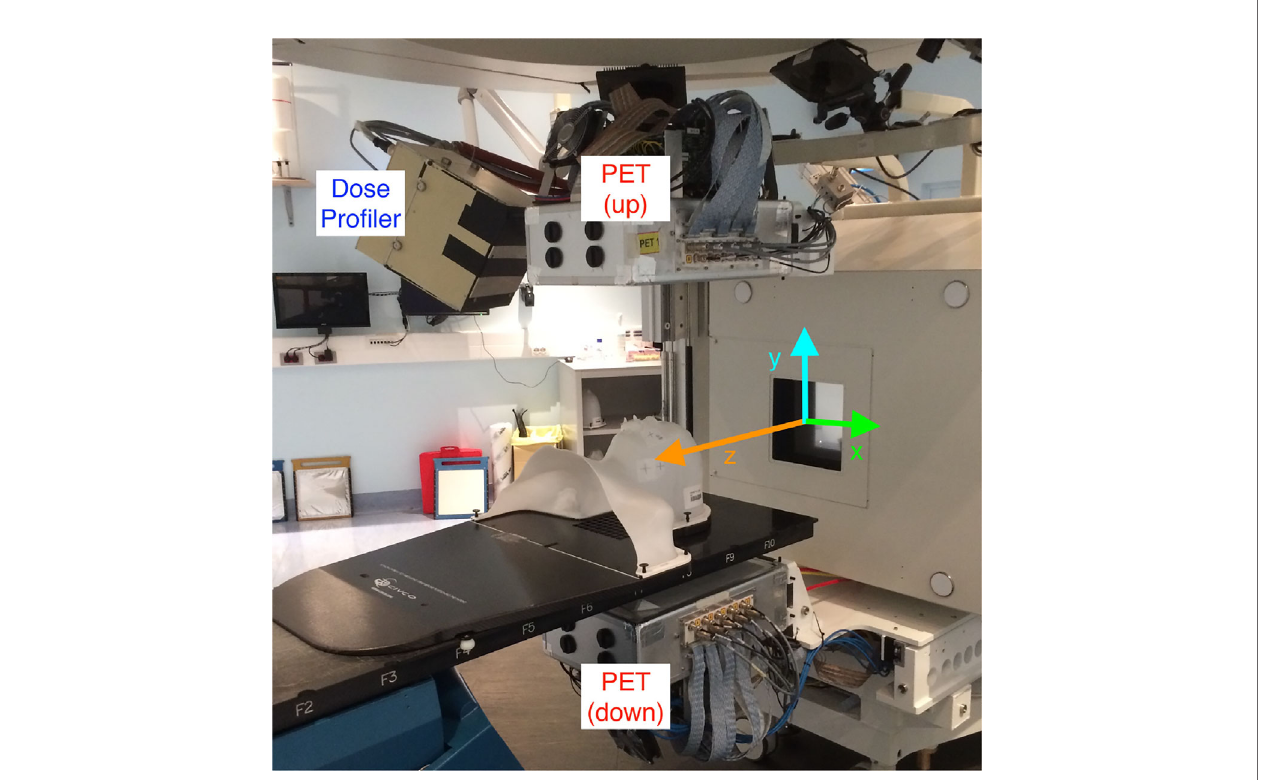
FIGURE 2 | View of the INSIDE cart holding the DP and the PET heads installed in the CNAO treatment room 1. A patient mask is attached to the bed to show the patient position with respect to the DP during a treatment. The reference frame used to present the DP measurements is over-imposed (the z -axis, in orange, is along the incoming beam